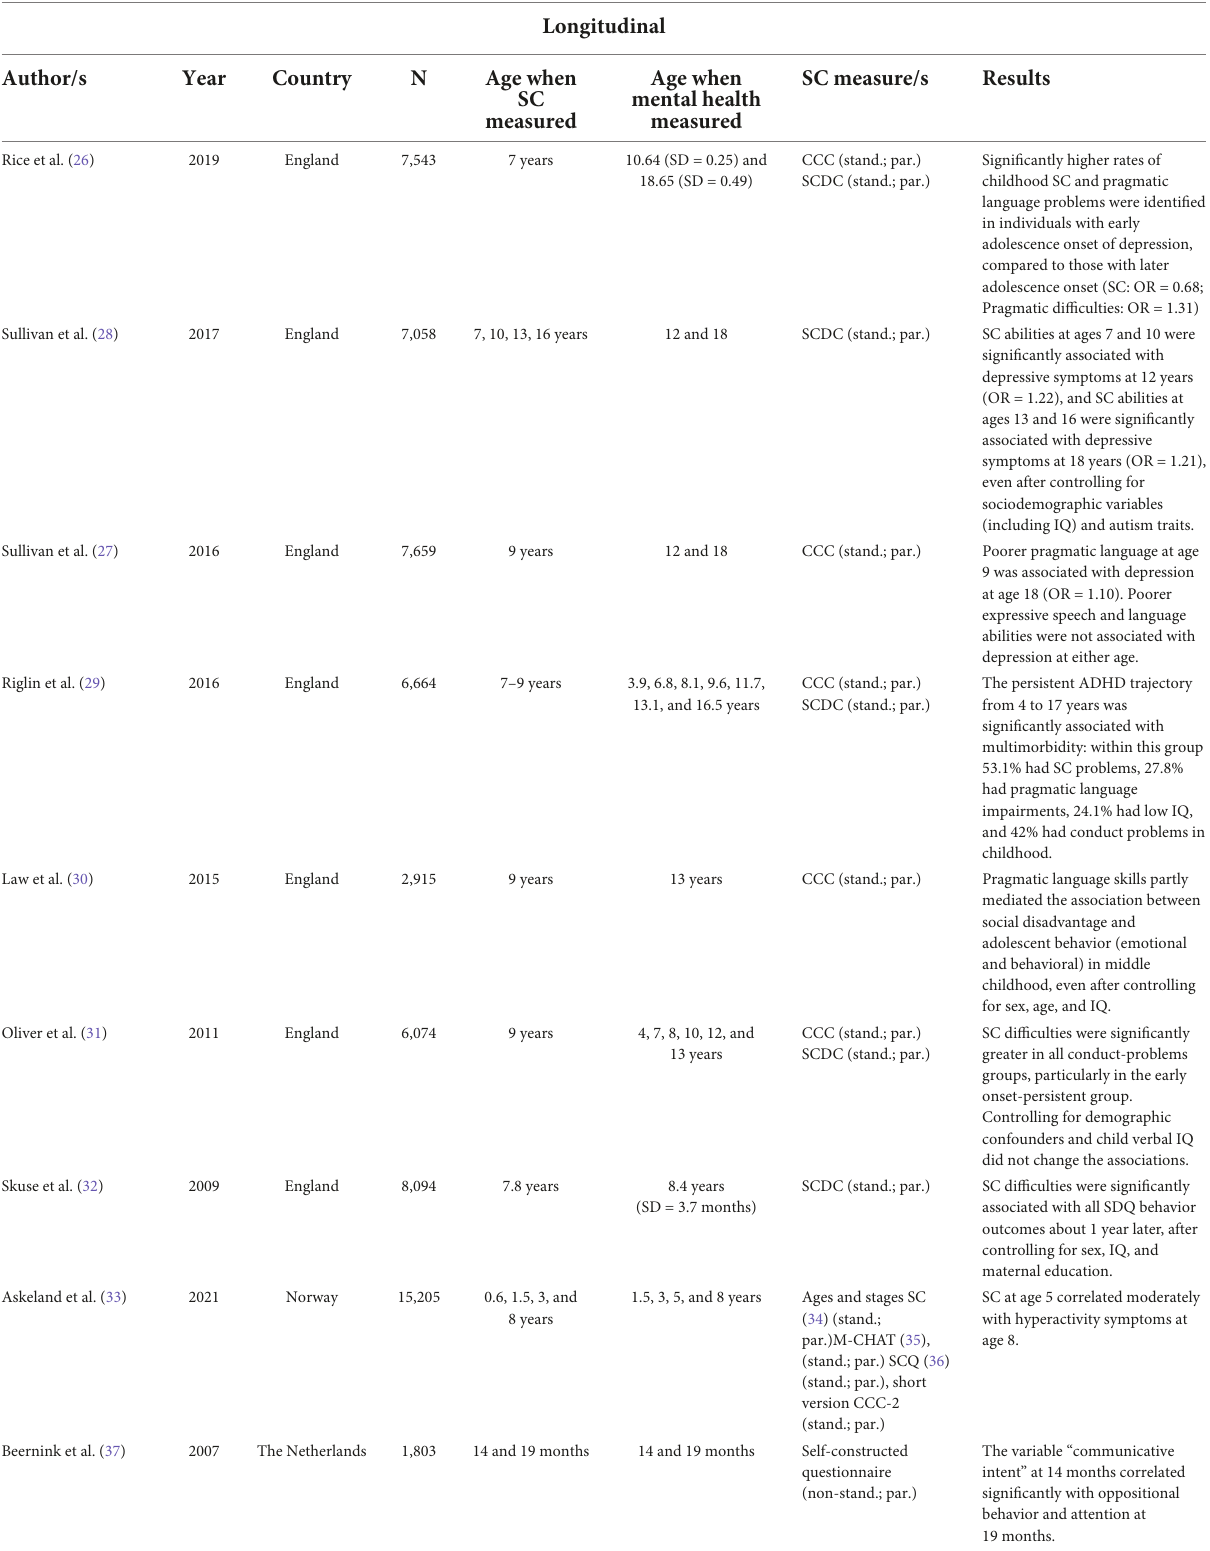
Population based